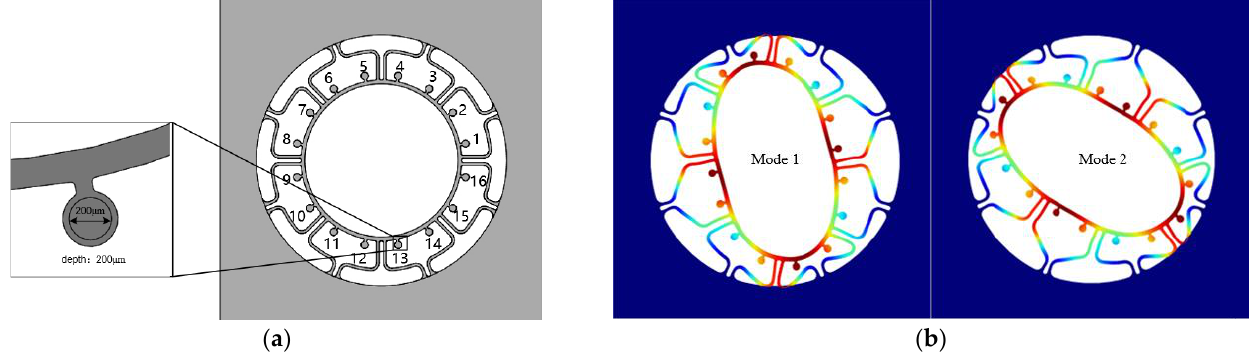
Figure 6. Resonator with processing errors and its modal simulation. ( a ) Resonator with processing errors; ( b ) Modal simulation.